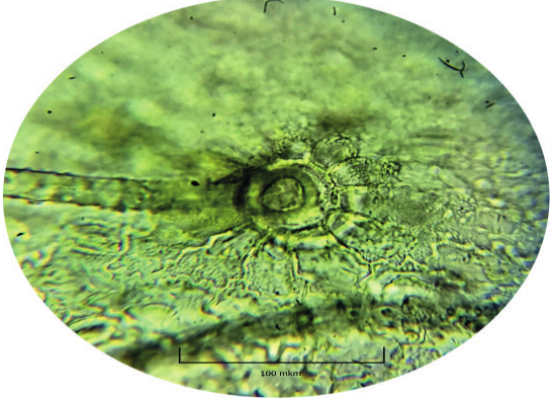
Figure 2. T. pratense L. leaf epidermis trichomes